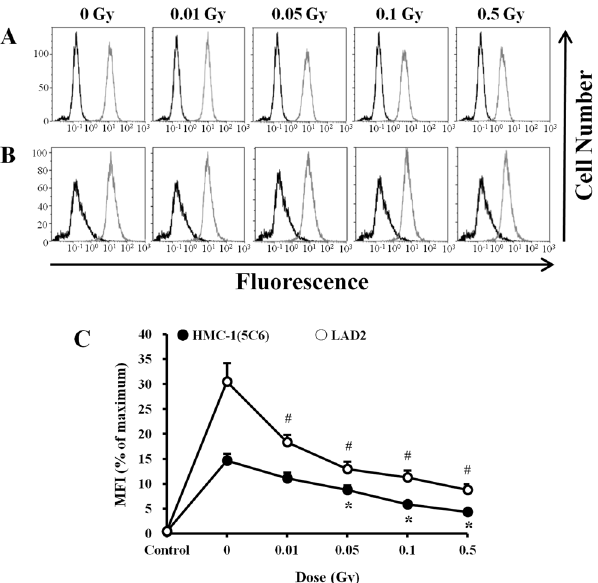
Fig 5. Effects of ionizing radiation on Fc ε RI expression in human mast cells. HMC-1(5C6) (A) and LAD2 (B) cells were incubated for 30 min in medium containing human IgE and exposed to 0 – 0.5 Gy ionizing radiation. Thirty minutes after irradiation, cells were incubated with FITC-conjugated human anti-IgE for 30 min. Fc ε RI expression was evaluated with flow cytometry. (C) The mean fluorescence intensity (MFI) is expressed as the mean ± SEM relative to the mean maximal MFI (100%). Data are representative of three experiments. * p < 0.05, #p < 0.05 versus the corresponding control group of HMC-1(5C6) and LAD2 cells,